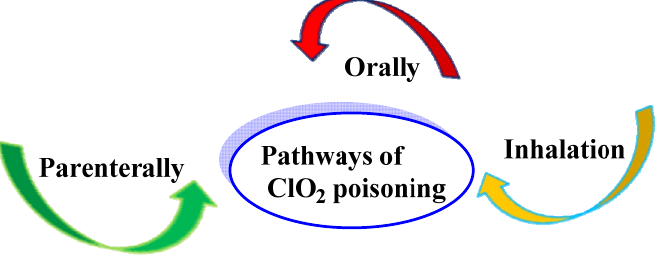
Figure 44. The main routes of ClO 2 poisoning.